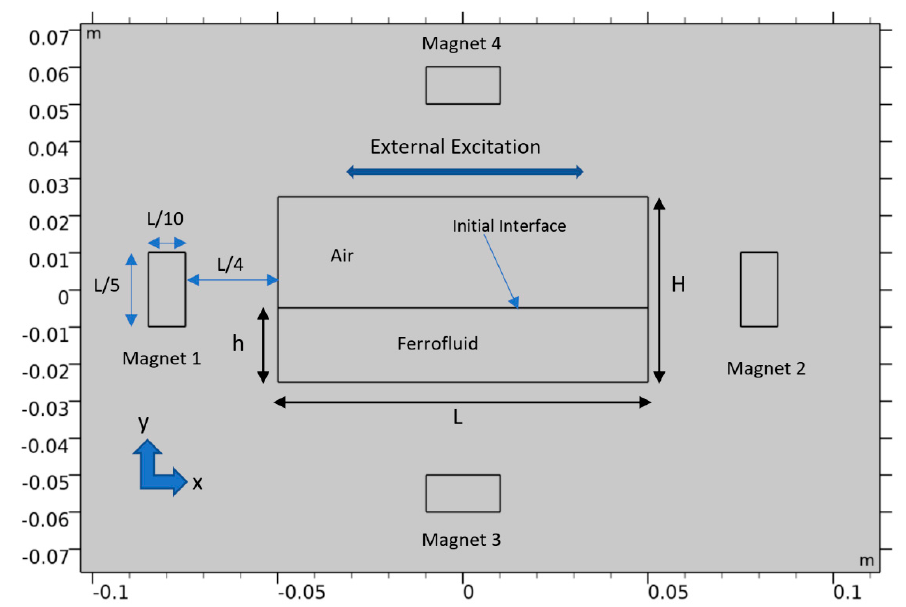
Figure 3. Schematic representation of the proposed harvester configuration.